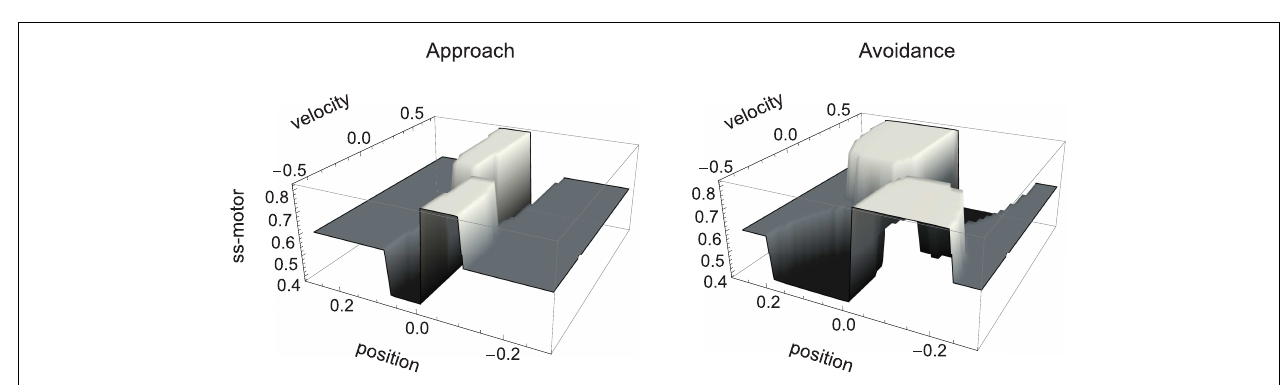
given position. Black attractor regions correspond to negative and white regions to positive steady-state velocities. Gray areas indicate bistable regimes.